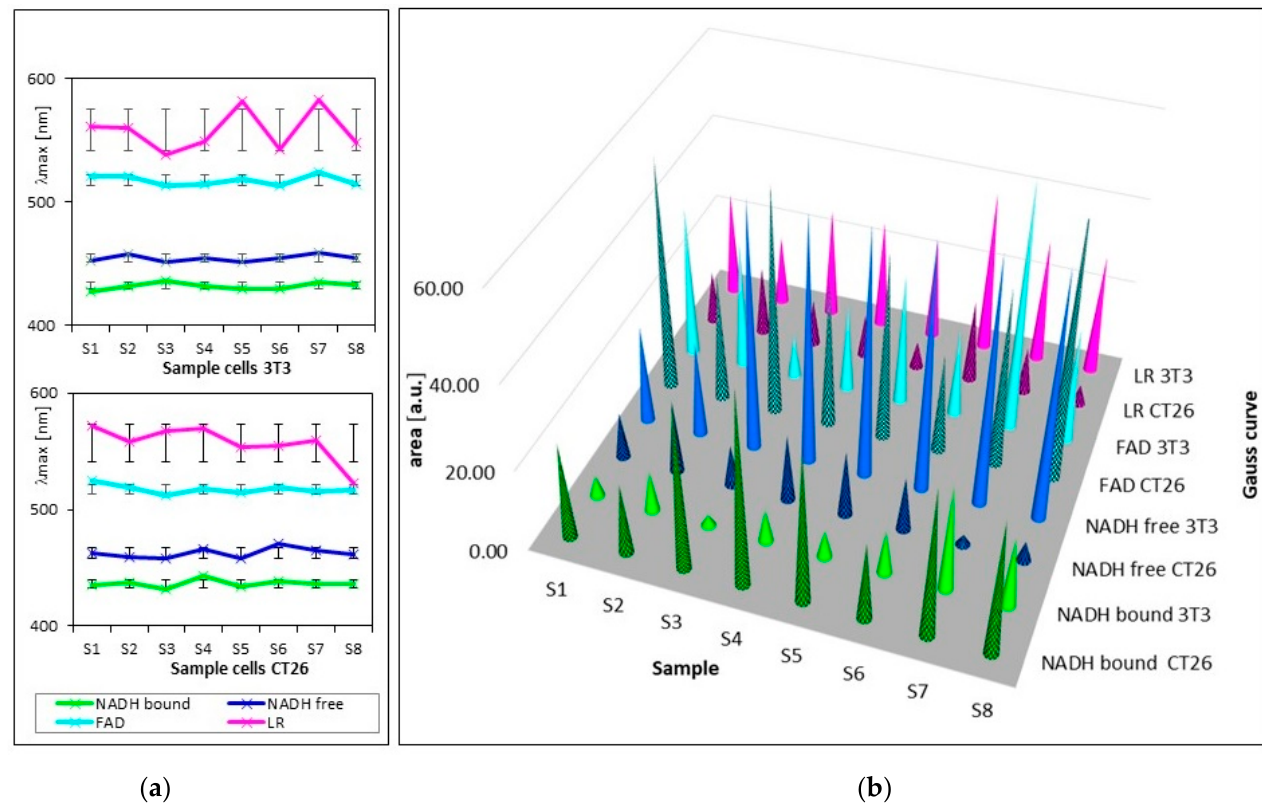
Figure 3. Parameters of calculated curves of deconvoluted spectra of 8 samples of living healthy 3T3 and cancer CT26 cells. ( a ) wavelengths of maxima of calculated Gauss curves (line segments are mean squared deviations σ ); ( b ) areas under calculated Gauss curves. Table 2. The ratios of areas under calculated Gauss curves of free and bound NADH, AF/AB at pH 7 in deconvoluted spectra of 8 samples of healthy cells 3T3 and carcinoma cells CT26.